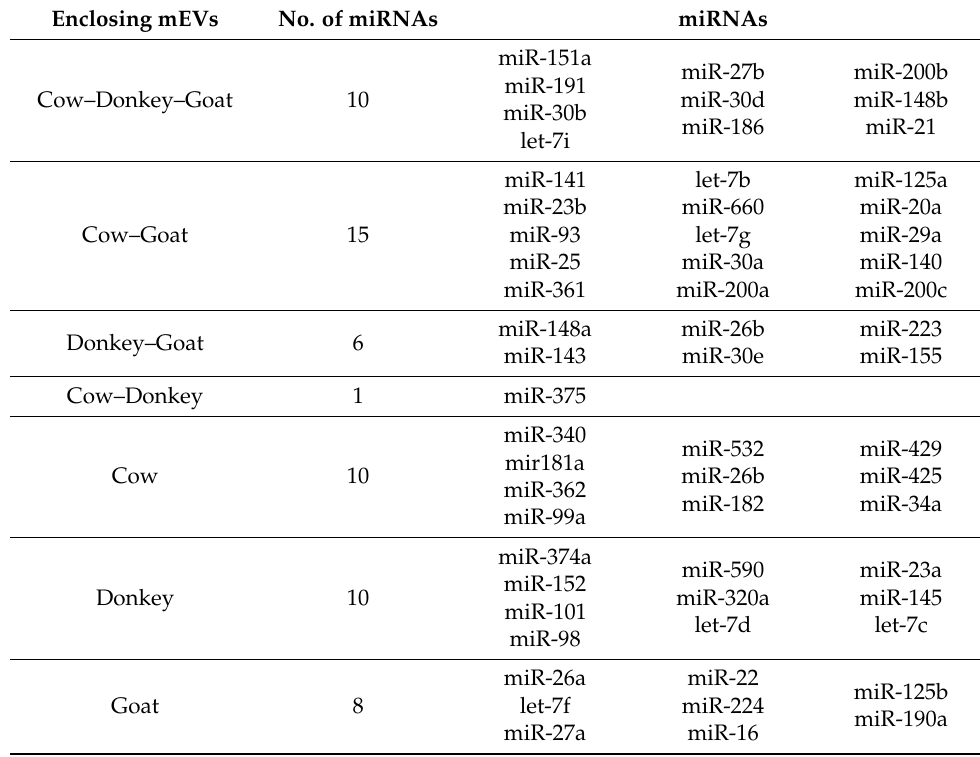
Table 1. Most expressed miRNAs (covered by 95% RPKM) in mEV species cargo.